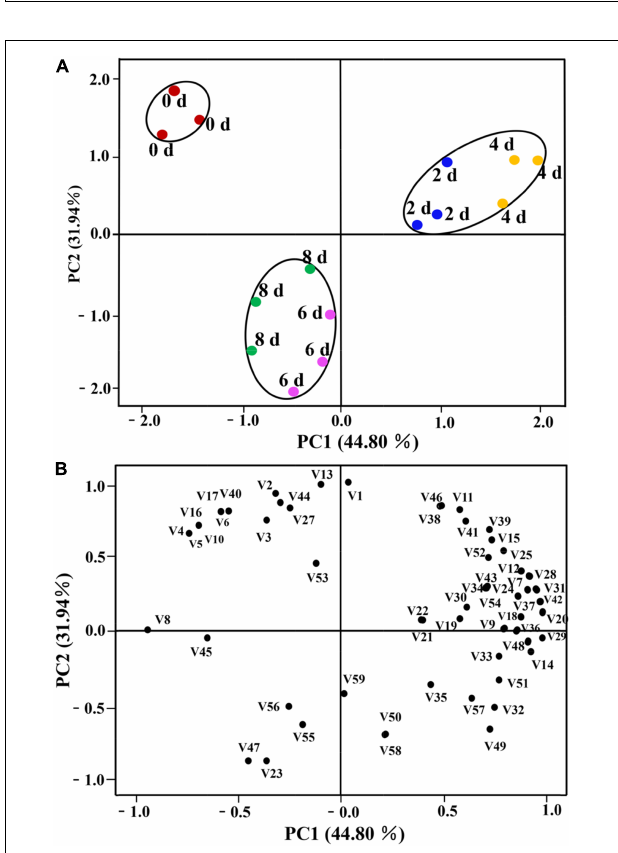
FIGURE 7 | Principal component analysis of cut lilies in different days after harvest and 59 volatile compounds. (A) Score plot; (B) loading plot. The number code after “V” in (7B) also corresponds to the volatile code in Table 1 .